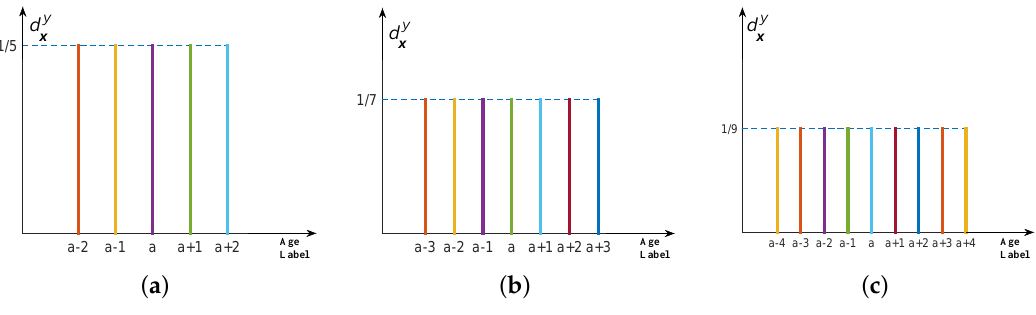
Figure 8. Different number of age labels when generating age label distribution as multi-label with equal description degrees for the chronological age a . ( a ) number of age labels: 5; ( b ) number of age labels: 7; ( c ) number of age labels: 9.